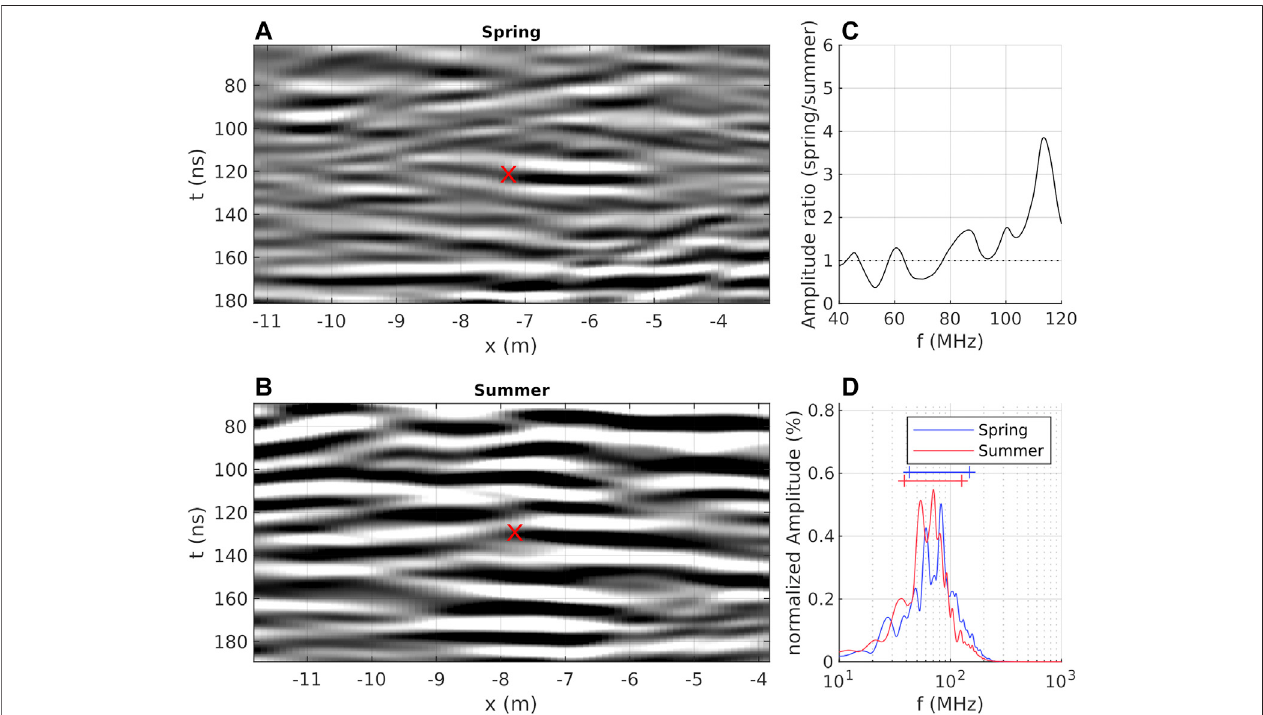
FIGURE 7 | Exemplary 2D detail in time (A,B) and frequency domain (C,D) . 2D data were extracted from our migrated (A) spring and (B) summer data cube (betweenx= − 11and − 4 m,aty=21 m),andmanuallyalignedbasedonimagedetails(redmarkeratcenter). Note,againfactoroftwohasbeenappliedtothesummer data for visualization. Right column: (C) ratioof unnormalized amplitude spectra around ournominal antenna frequency and (D) normalized amplitude spectra for spring (blue)andsummer(red) data.In (D) ,horizontallines denotefrequencyrangebetween10thpercentileA 10 and90thpercentile A 90 (comprising80%oftherecorded